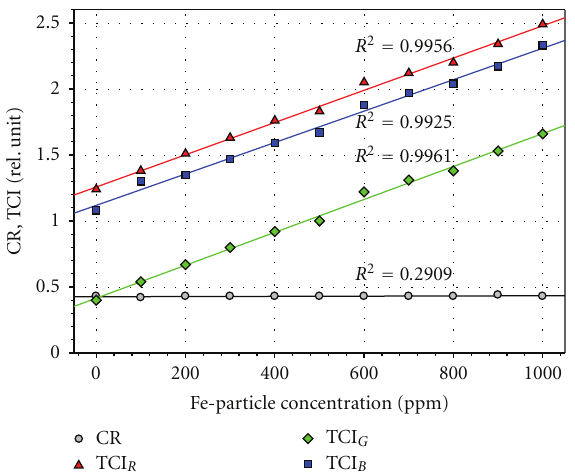
Figure 9: CR, TCI variation with Fe-particulate contamination in T100 oil.